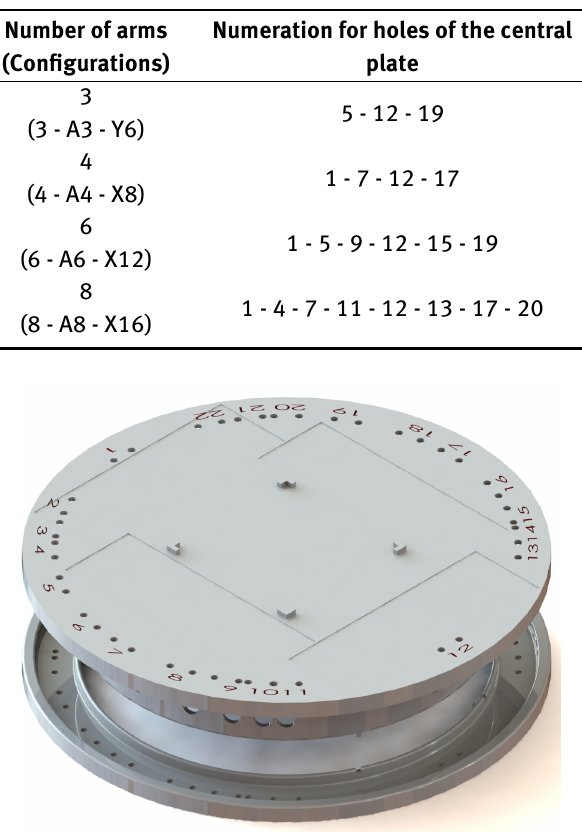
Table 1: Number of arms and numeration of the holes to use for the several possible configurations.